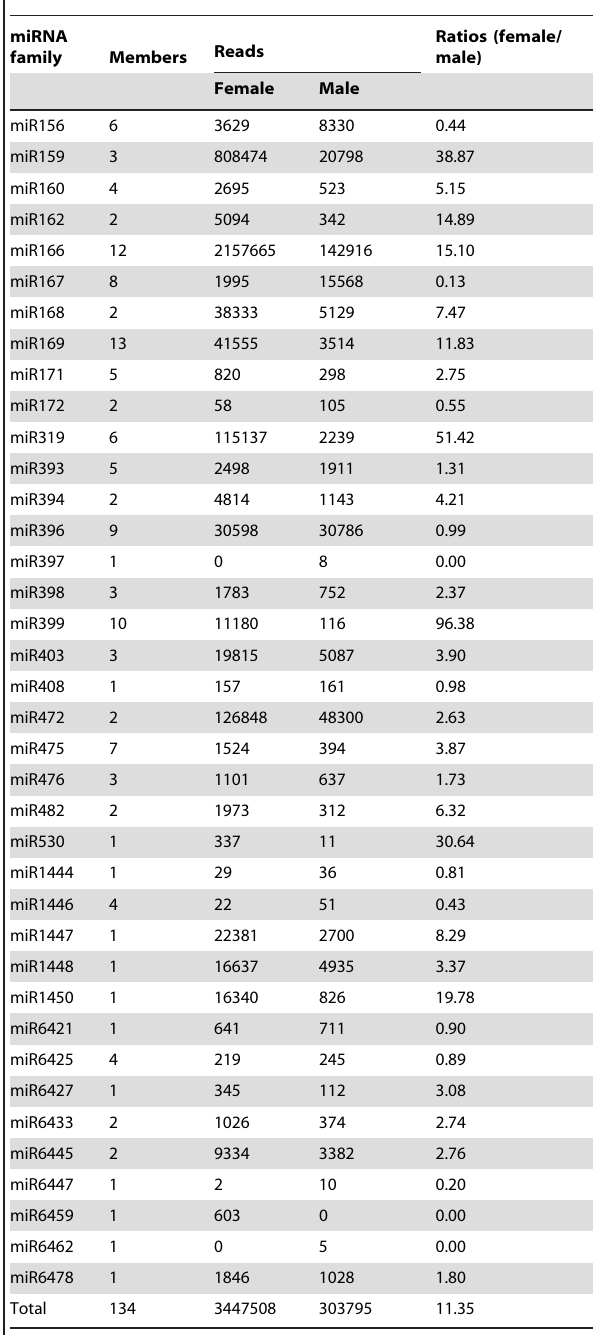
Table 2. Summary of conserved miRNAs found in andromonoecious P. tomentosa .